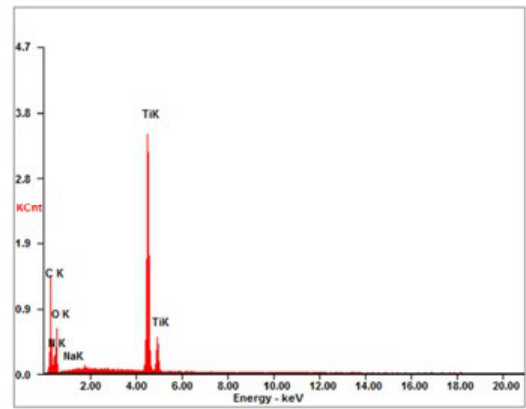
Fig. 4 (b): EDAX spectra of 10 % GO-nanotitania Fig. 4(b) EDAX spectra of 10 % GO-nanotitania composite Fig. 4(b) EDAX spectra of 10 % GO-nanotitania composite